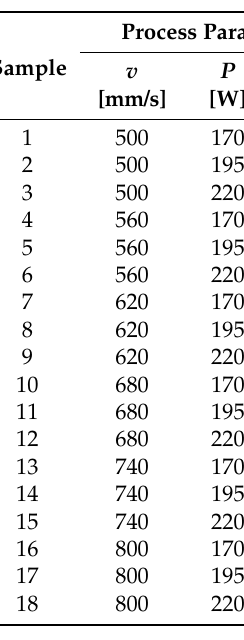
Table 3. Process parameters, density and hardness